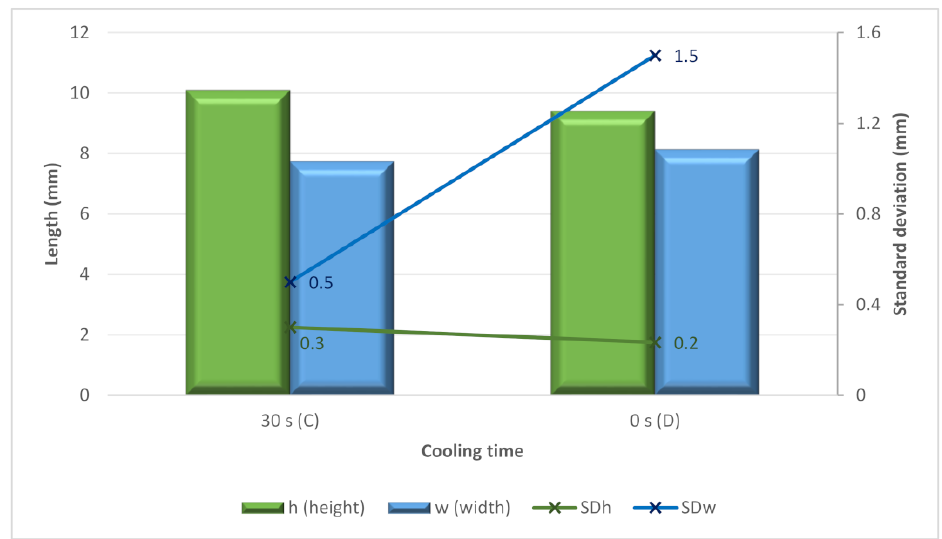
Figure 10. Height, width, and standard deviation for the C and D samples versus the cooling